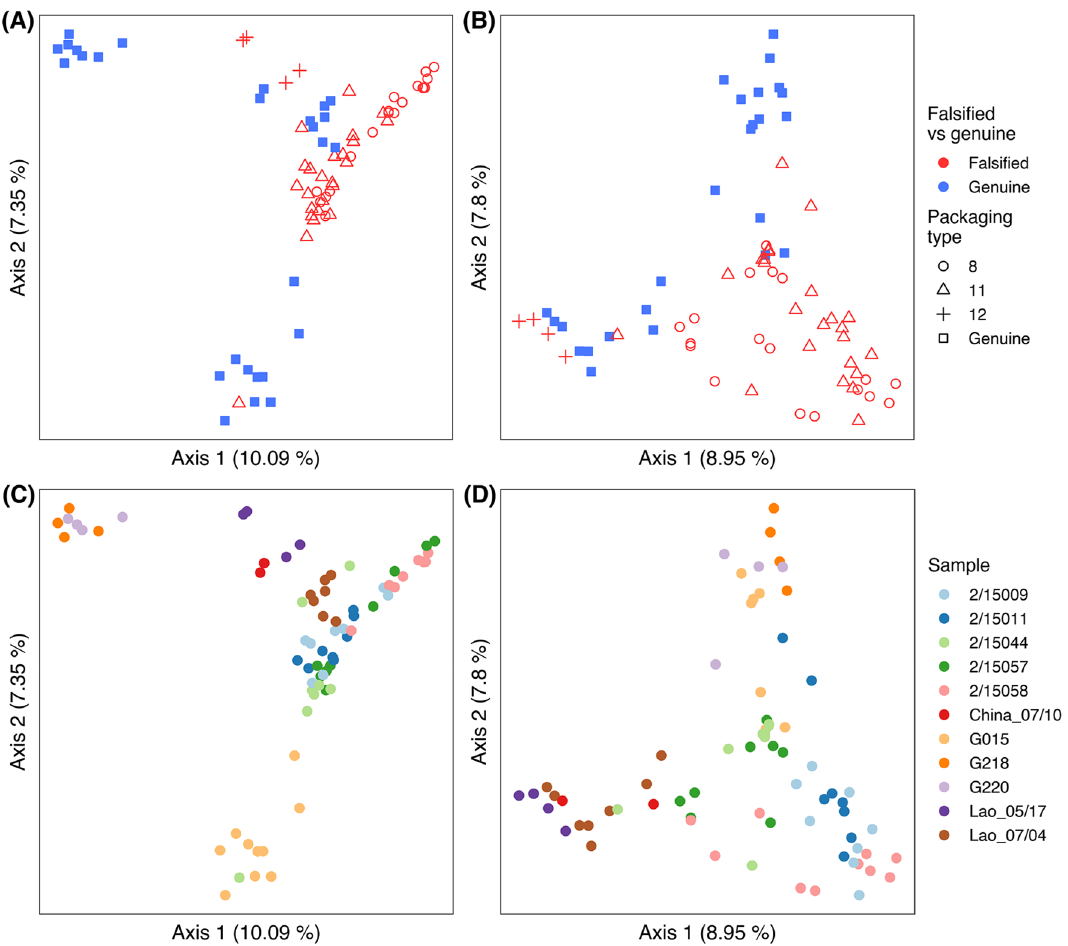
Figure 1. Bray–Curtis Principal Coordinate Analysis of 16S rRNA data in: ( A and C ), rarefied at 1200 sequences; and 18S rRNA data in ( B and D ), rarefied at 160 sequences. Falsified vs genuine (with packaging type for falsified samples) are shown in ( A and B ), while individual samples are shown in ( C and D ). PERMANOVA testing (see “Results and discussion ”) reveals compositional differences between genuine and falsified tablets, and between different packaging types (within falsified